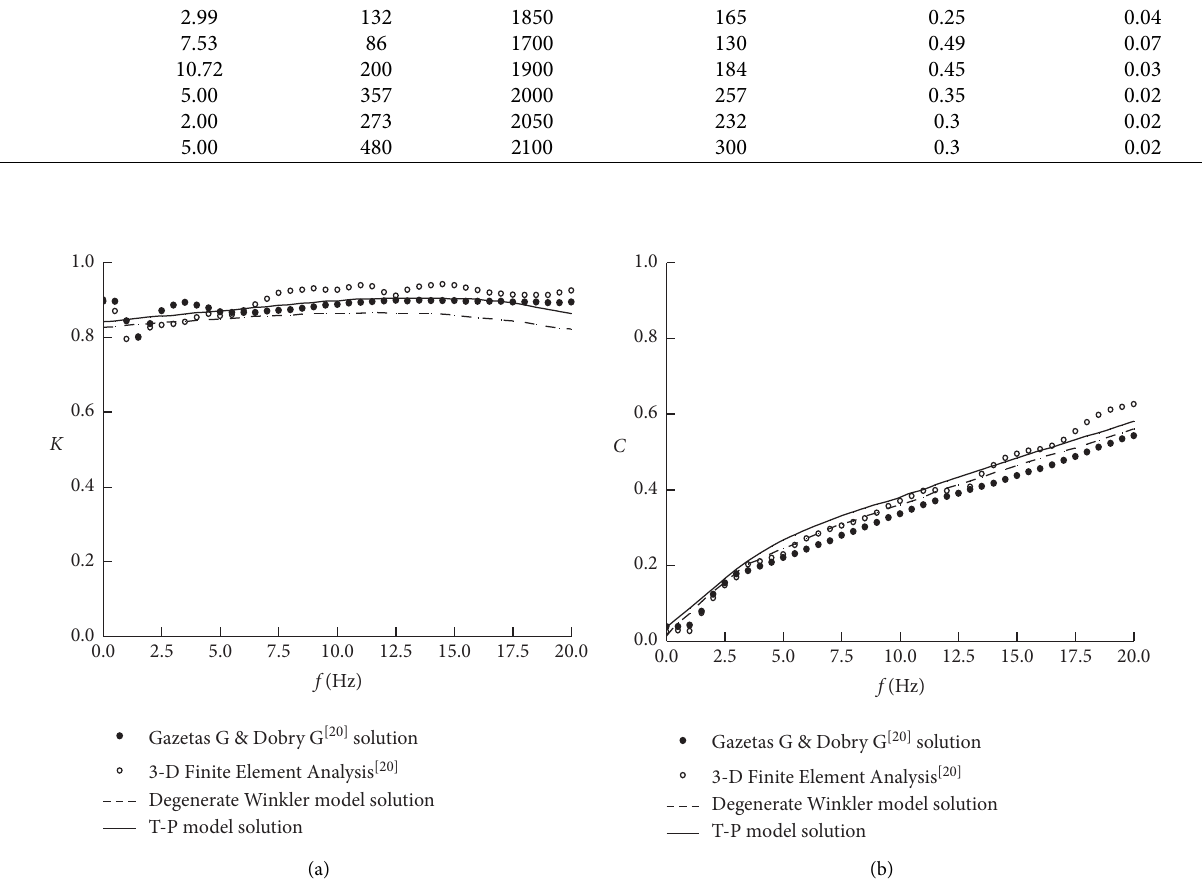
Figure 3: Variation in pile top impedance with frequency in layered soil. (a) Horizontal relative dynamic stiffness. (b) Horizontal relative dynamic damping.